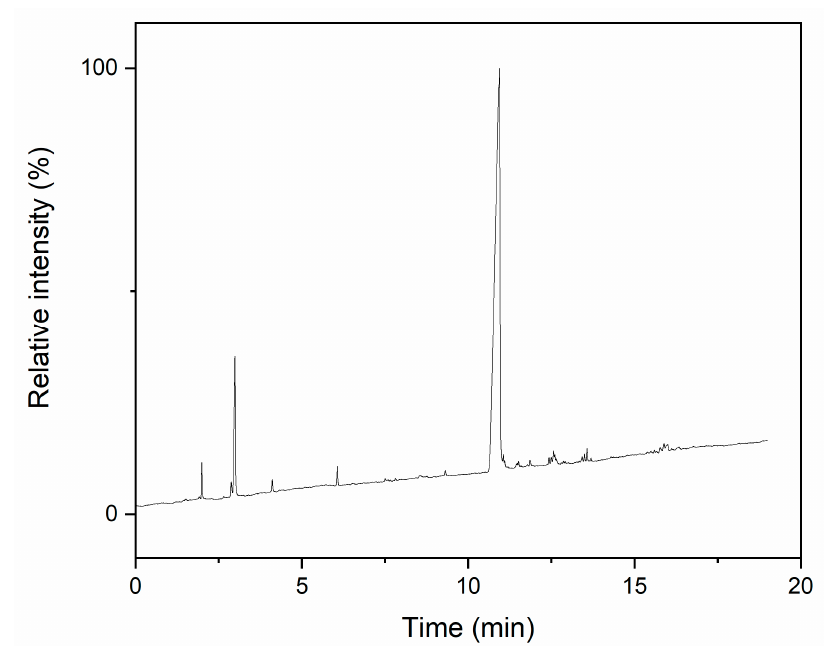
Figure 3. GC chromatogram of final product from initial synthesis.